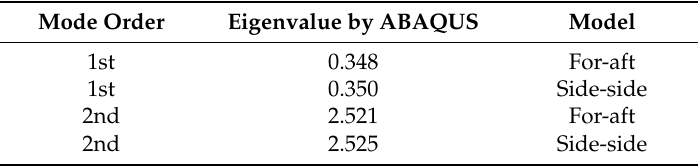
Table 5. Structural dynamic properties in ABAQUS eigenvalue